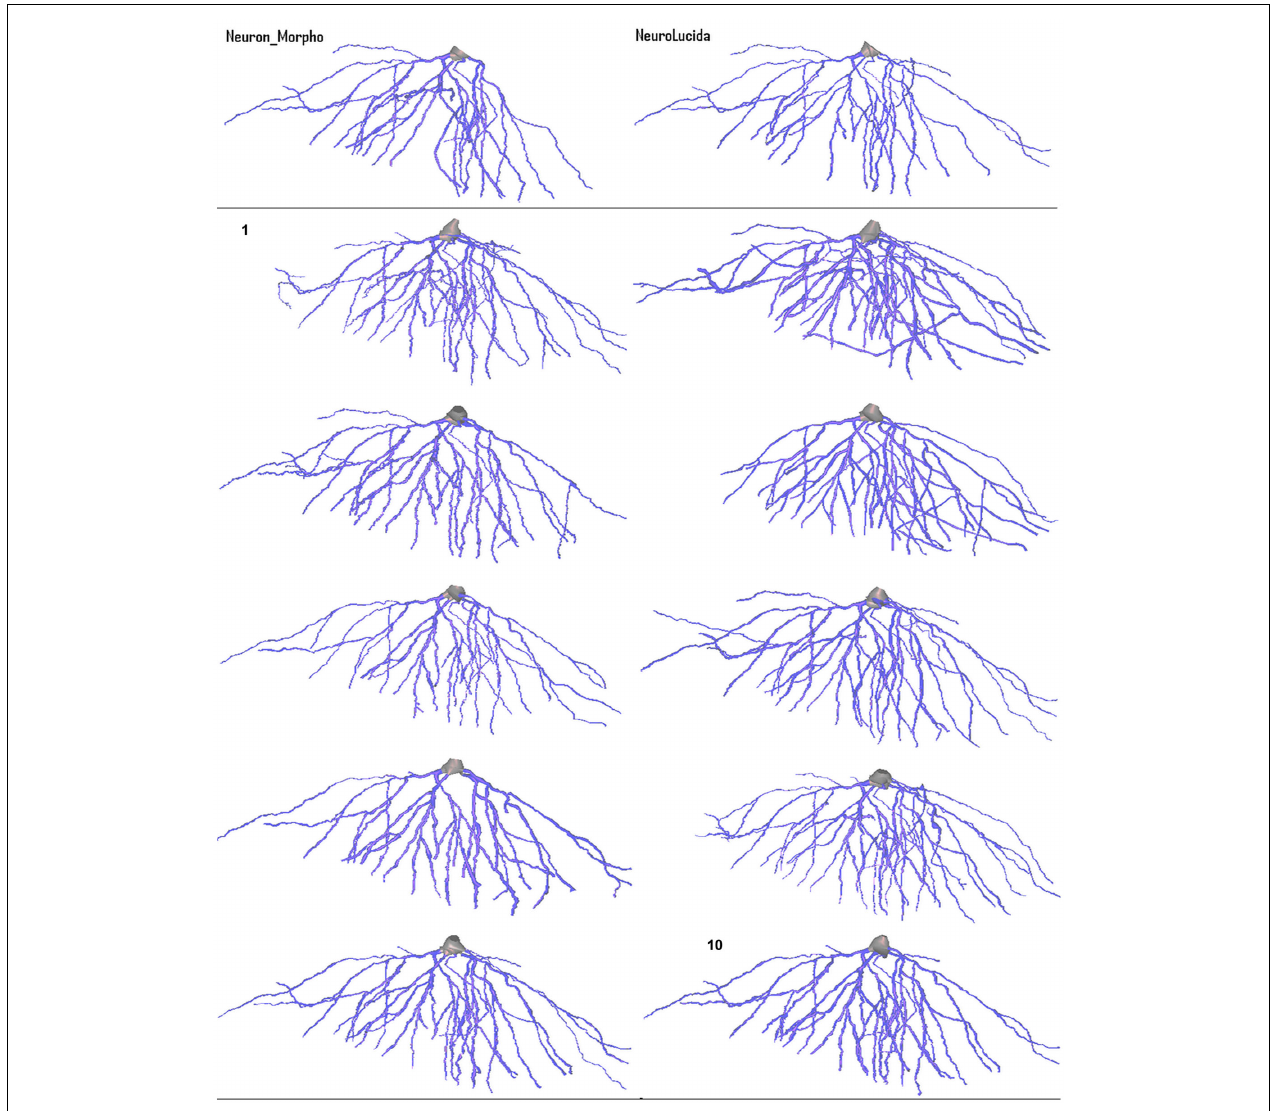
FIGURE 5 |Variation in morphology of the 10 basal tree reconstructions created by the participants in the experiment (they are in ascending order from left-to-right). The Neuron_Morpho reconstructions and Neurolucida reconstructions presented in Brown et al. (2005) are shown to allow visual